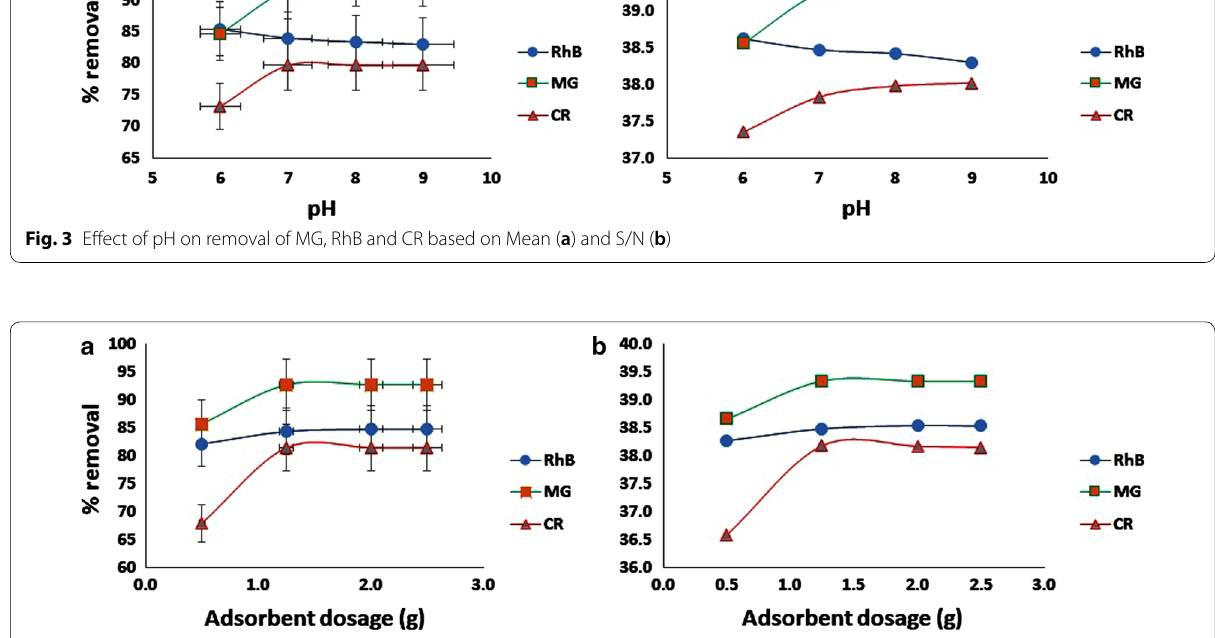
Fig. 4 Effect of adsorbent dosage on removal of MG, RhB and CR based on Mean ( a ) and S/N ( b